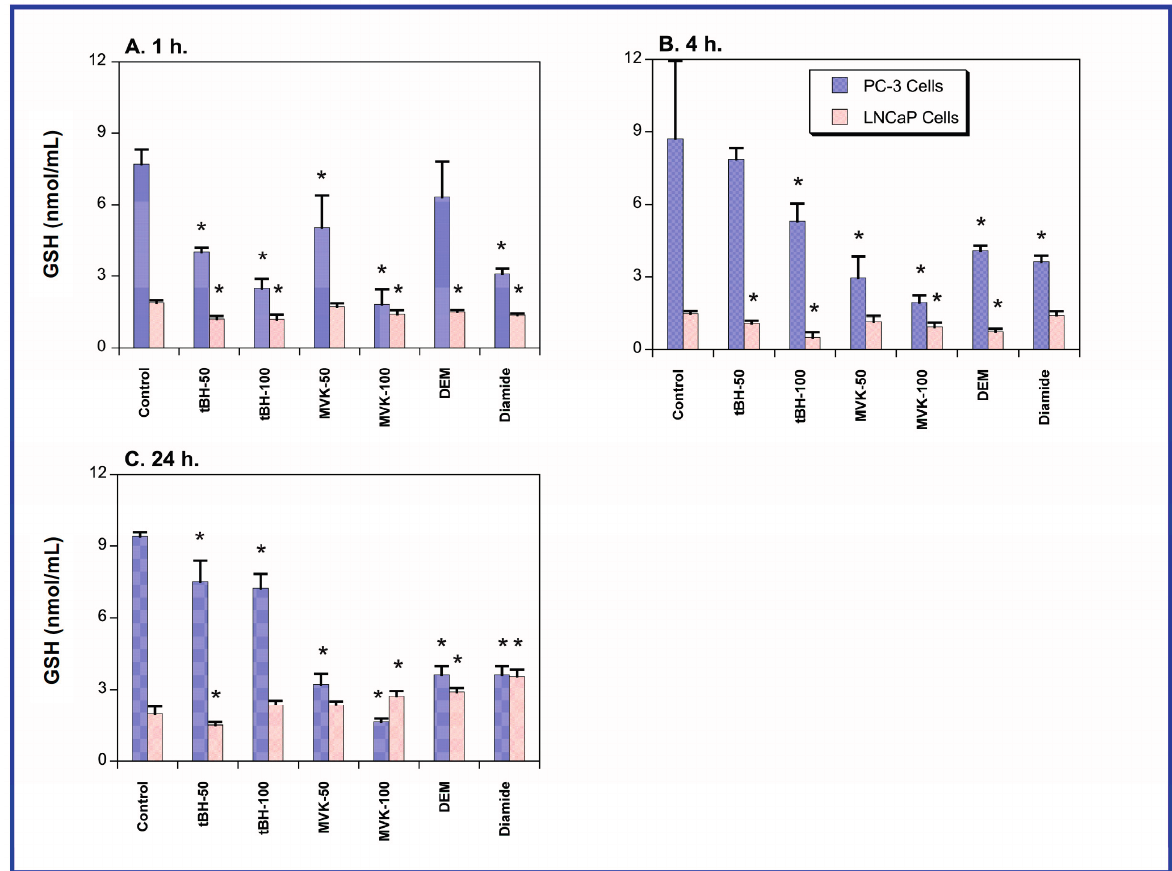
Figure 2. GSH content in PC-3 and LNCaP cells. GSH was measured in total cell extracts by use of Ellman’s reagent and measurement of A 412 . GSH content was calculated from a GSH standard curve. Results are means ± SEM of measurements from six separate